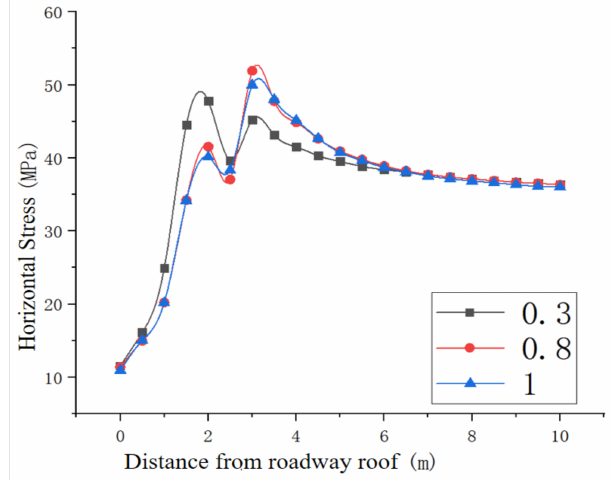
Figure 12. Horizontal stress distribution of surrounding rock of soft sandwich roadway with different